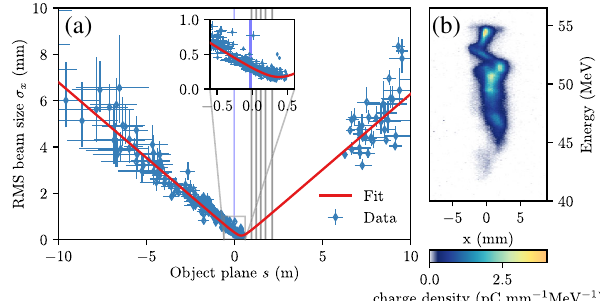
FIG. 6. (a) Scan of the imaging quadrupole focusing strength. Each data point represents a single event with an injected witness beam. Transverse beam sizes on the spectrometer screen and mean Lorentz factor h γ i were calculated from the spectrometer signal. From the quadrupole strength and h γ i , the object plane s and the magnification were calculated to extract σ x ð s Þ at the corresponding object plane. Error bars on σ x and s were calculated analogously based on the rms energy spread. The exit of the capillary (shown as a light blue line in (a) and the inset) is at s ¼ 0 . Object planes in the range between s ¼ 0 . 5 m – 5 . 9 m lie too close to the quadrupoles (shown as gray lines) to be imaged. (b) An example of a witness- beam signal as measured on the spectrometer